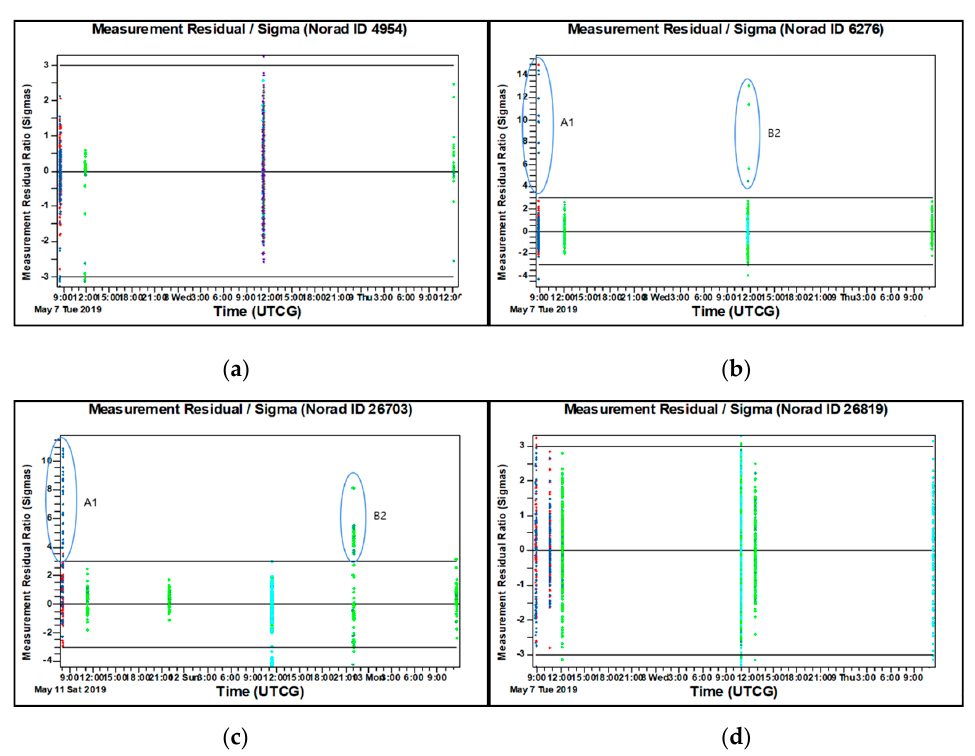
Figure 4. The residual ratio of tracking data, the blue and red from A1 are all angle data, the green and cyan from B2 are angle and laser ranging data, respectively. ( a ) ID4954; ( b ) ID 6276; ( c ) ID 26703; ( d ) ID 26819.